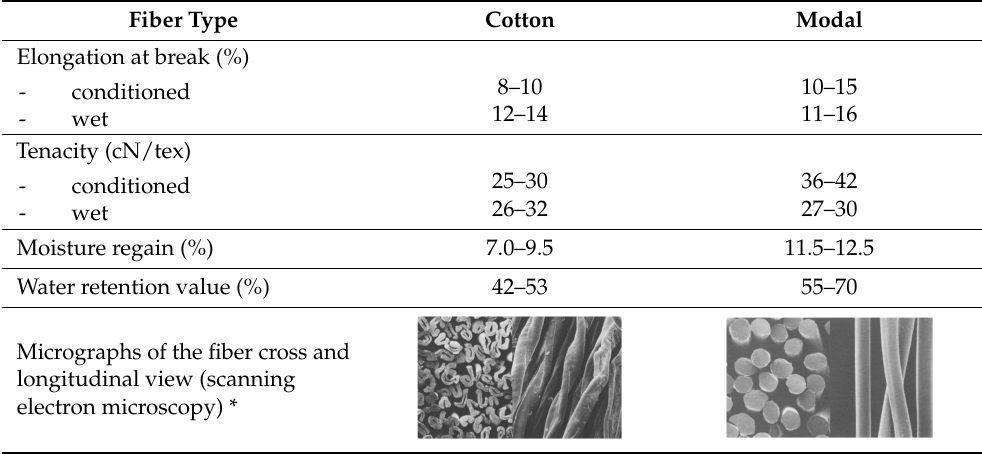
Table 1. Properties comparison of cotton and modal staple fibers [6–8].